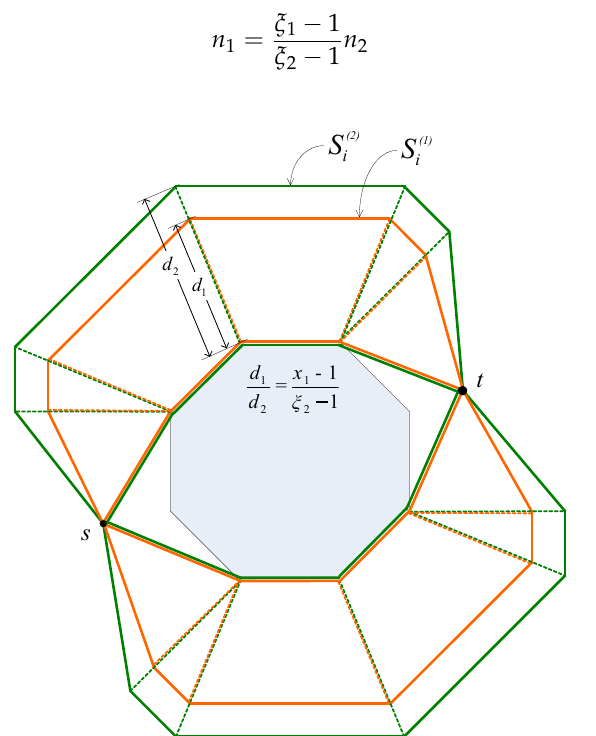
Figure 5. Comparison of the areas of B 1 and B 2 . In order to compare B 1 and B 2 , we divide them into sub-regions by dotted lines